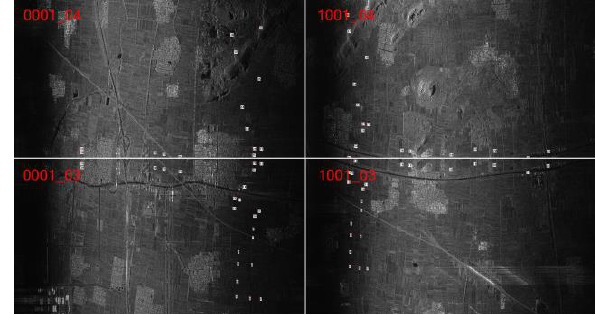
Fig.9 Tie Points’ Distribution for Data 0001_04, Data 0001_03,